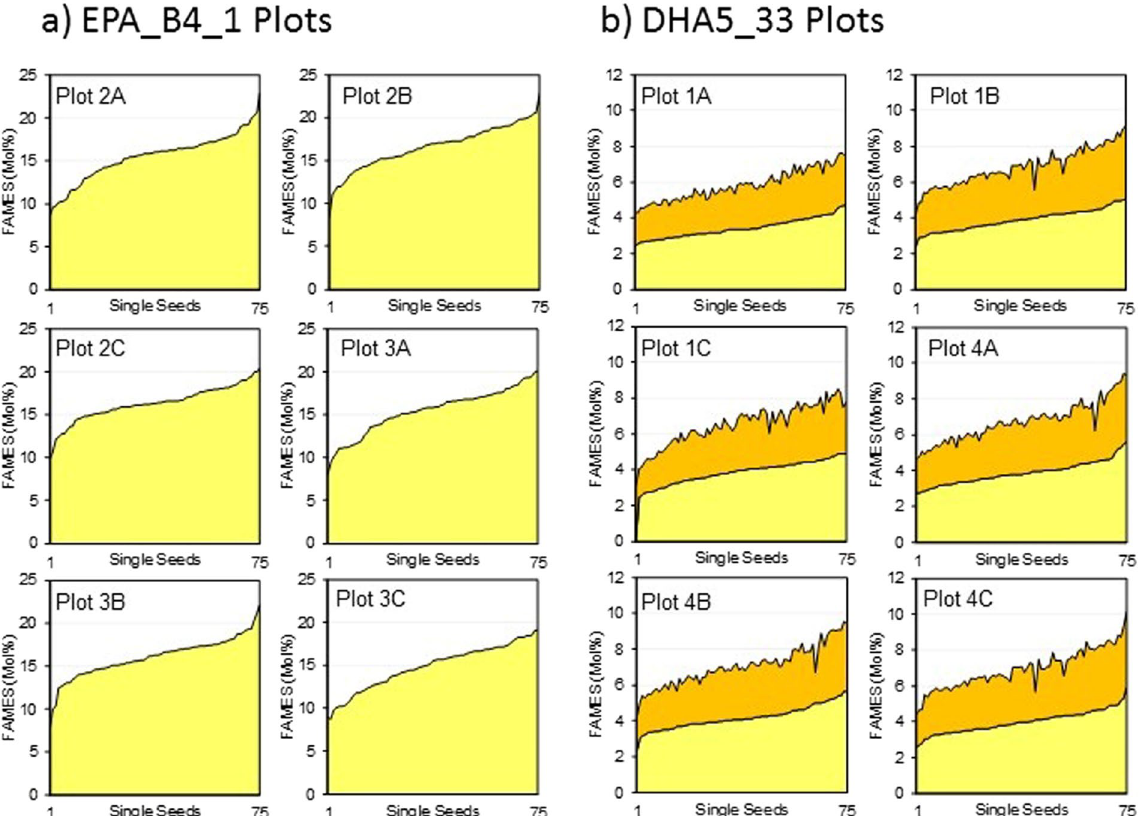
Figure 3. The accumulation of EPA and DHA in transformed field-grown seeds of C. sativa . The levels of specific n-3 EPA and DHA are shown in ( a ) and ( b ) for the individual sub plots of EPA_B4_1 and DHA5_33, respectively. The results are based on single seed analysis (n = 75); values for EPA are shown in yellow and DHA represented in